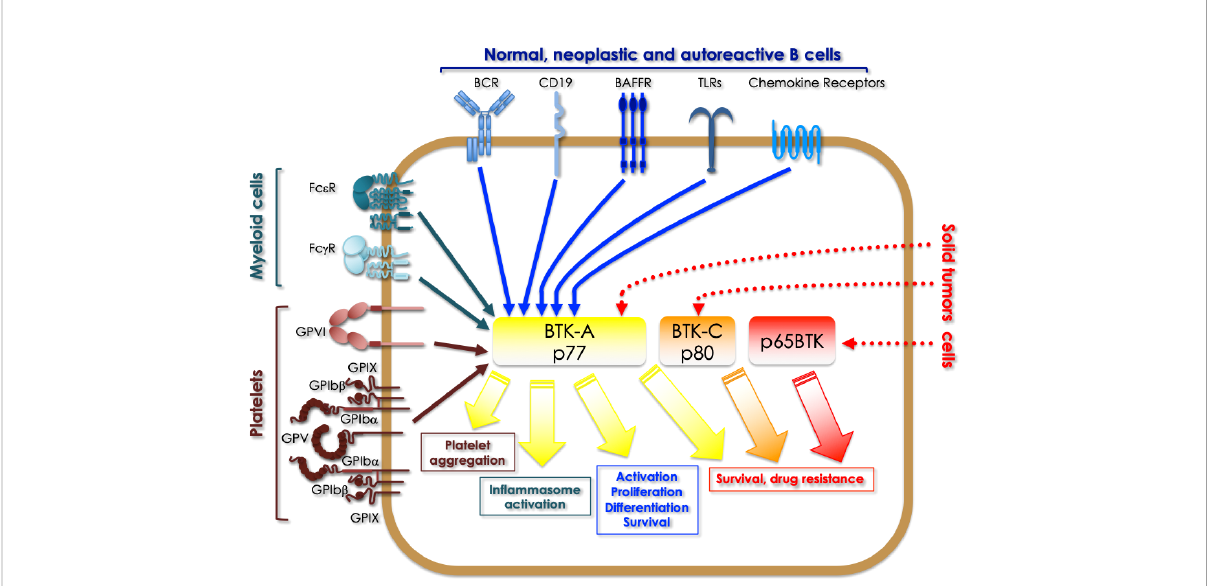
FIGURE 3 Overview of the signaling pathways where BTK isoforms are involved in different types of cells. BTK-A activation downstream of a series of receptors expressed in normal, neoplastic and autoreactive B cells (BCR, CD19, BAFFR, TLRs, chemokine receptors), regulates activation, proliferation, differentiation and survival signals. In myeloid cells the same isoform is activated by Fc e R and Fc g R and TLRs, which is crucial for the activation of the in fl ammasome. In platelets BTK-A activation is necessary for platelets aggregation triggered by the adhesive receptors. Finally, in some solid tumors, BTK-A pharmacological targeting has revealed its role in promoting the survival of cancer cells. A role for sustaining the survival of breast and prostate cancer cells has been demonstrated for the 80 kDa BTK-C isoform. Targeting p65BTK has proved to overcome the resistance of colon and non-small cell lung cancer cells to chemo- and targeted therapy, besides being a prognostic factor and an actionable target in glioblastoma and ovarian